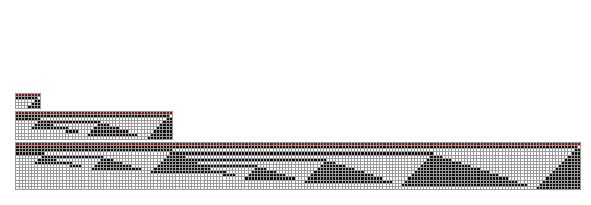
Figure 6: Execution of the Busy Beaver on the first three inputs.